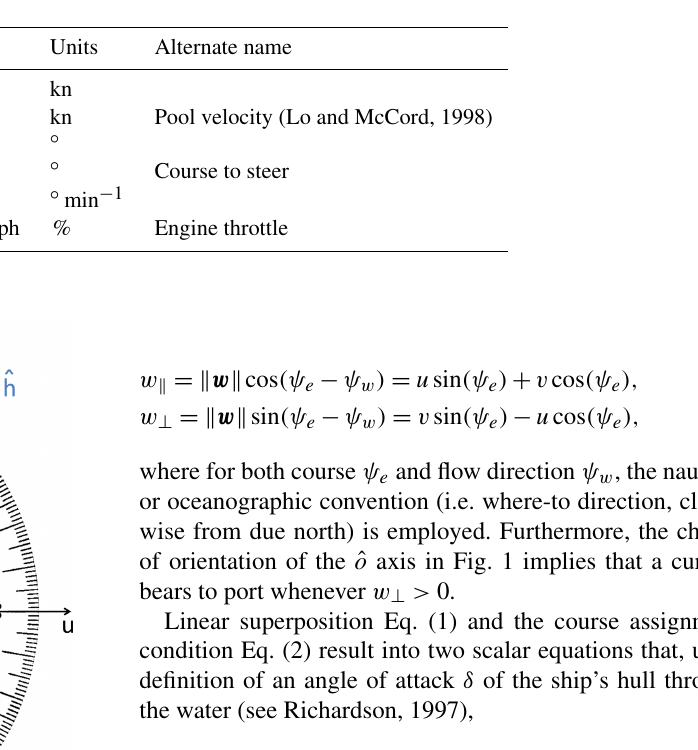
Table 1. Some nautical abbreviations used in this paper.